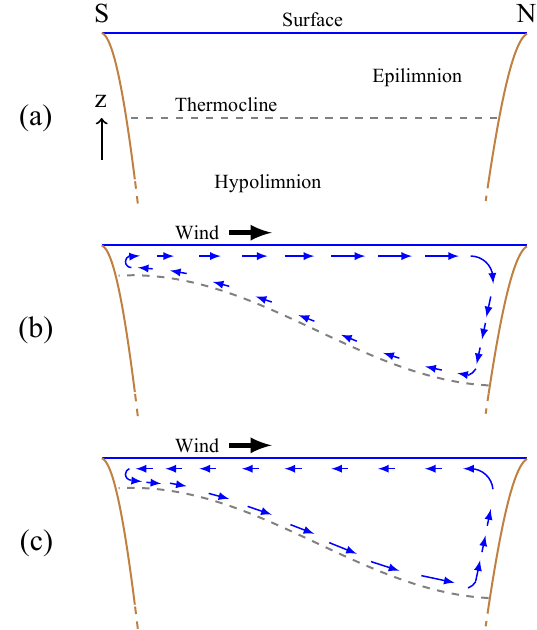
Figure 2. Schematic lake configuration with no wind stress (a) and with the southeasterly wind during the dry season in line with the classical circulation ( b , Mortimer, 1961), such that the surface water follows the wind, or according to the non-classical circulation ( c , Verburg et al., 2008) with reversed